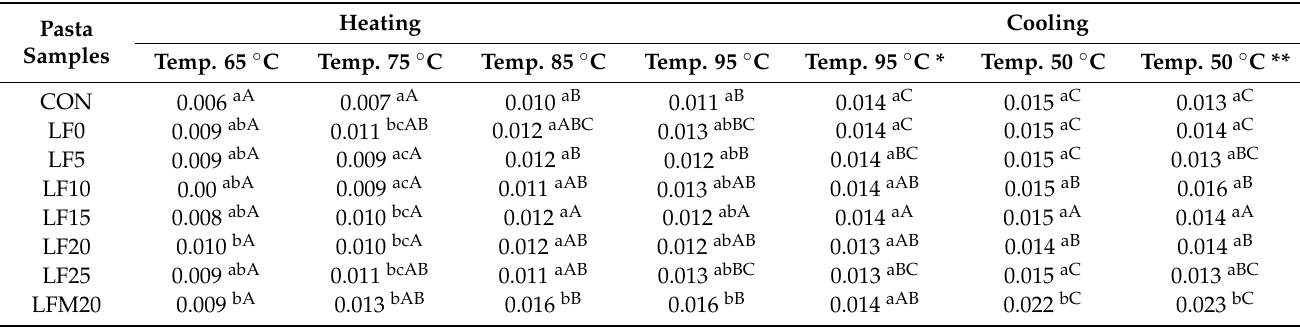
Table 3. The apparent viscosity of pasta samples